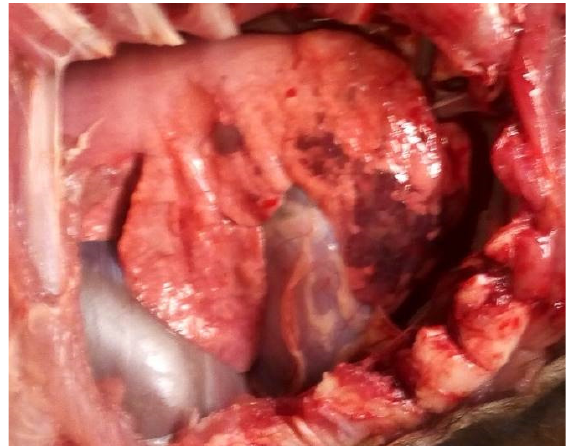
Fig. 4. The lungs showing patchy areas of lung consolidations in the cranial and middle lung lobes. This is consistent with super-infection with certain strains of